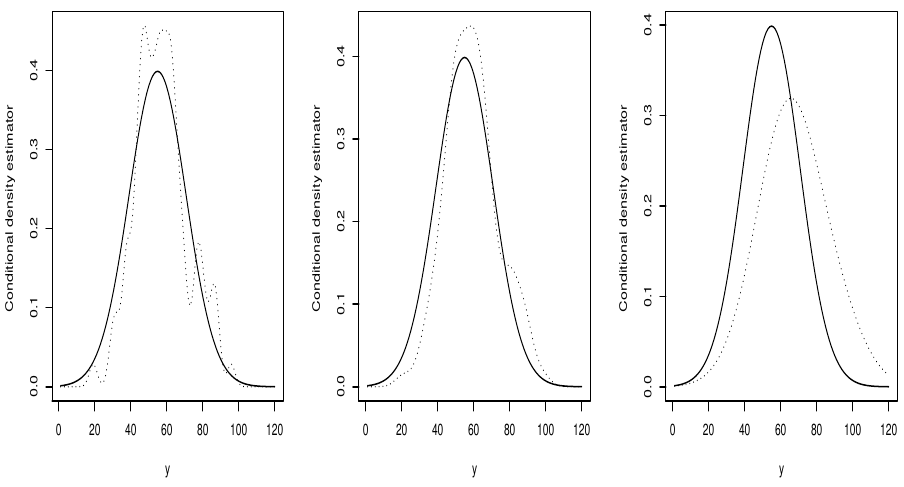
Figure 2. Comparison of different choice of ( ı ,  )) : Left plot: ( ı ,  ) = ( − 3, − 4 ) . Middle plot: optimal case ( ı ,  ) = ( 0,0 ) . Right plot: ( ı ,  ) = ( 3,4 ) . Dashed line: curve of (cid:101) f ( ·| X 0 ) . Continuous line curve of f ( ·| X 0 )